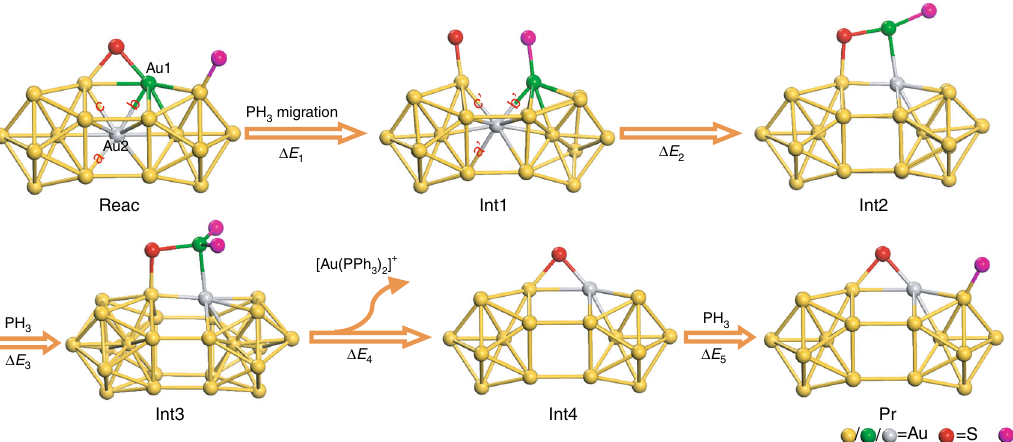
Fig. 4 Mechanisms for the formation of hollow Au 24 cluster proposed by DFT calculations. The values of interatomic distances are a = b = c = 2.97, a ′ = 3.23, b ′ = 2.90, and c ′ = 2.86 Å. DFT results show Δ E Au2, gray; other Au, yellow; S, red; P, magenta. Other atoms and bonds are not shown for clarity